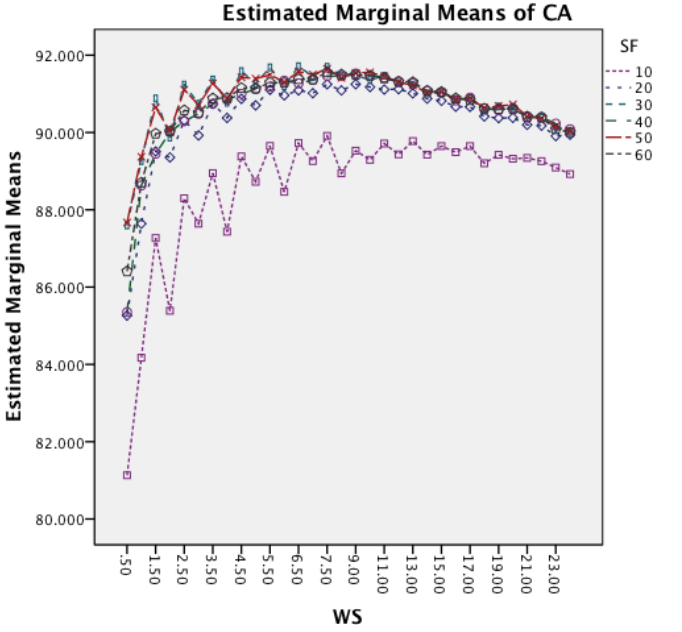
Figure 8. Two-way interaction effect for WS and